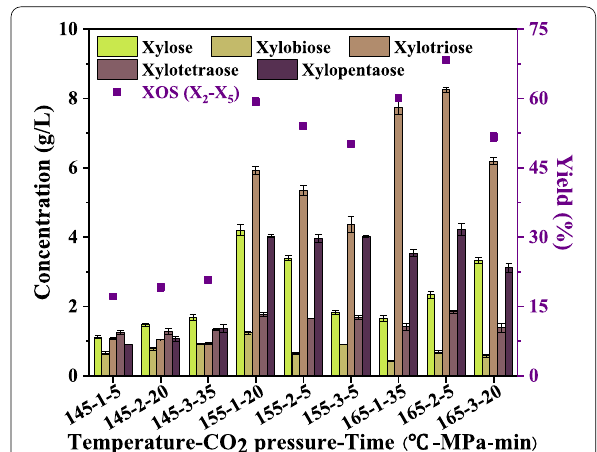
Fig. 1 Xylose and XOS concentrations and XOS yield under different treatment conditions